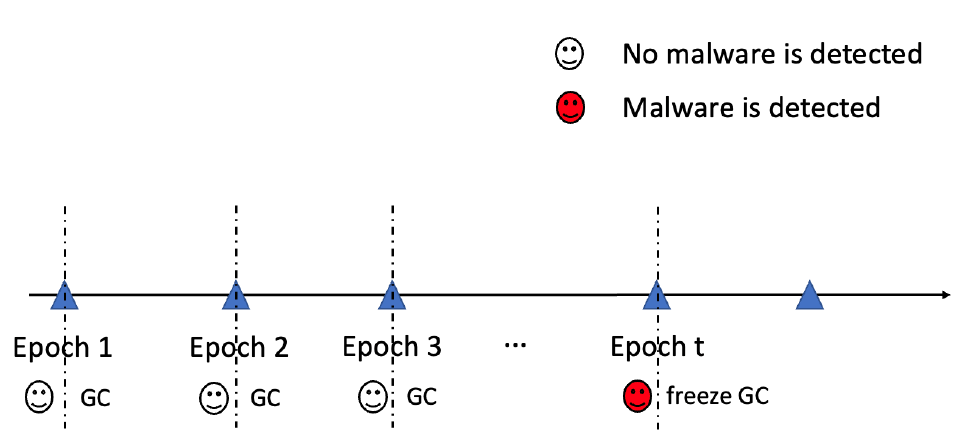
Figure 7. Malware detection-aware garbage